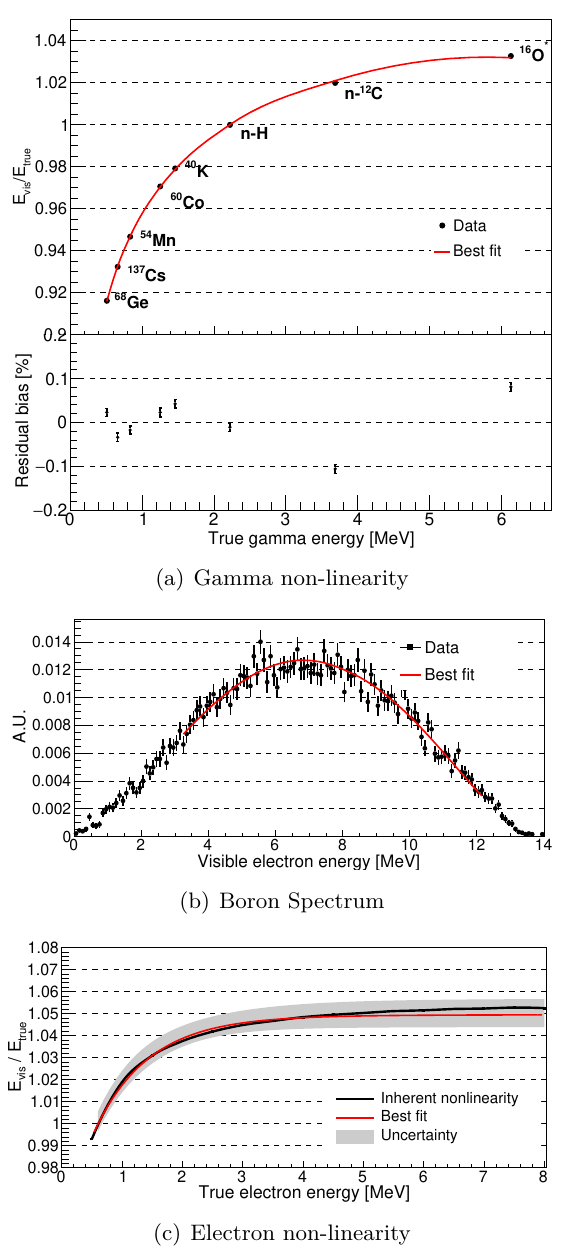
Figure 1 . Fitted and simulated gamma non-linearity (a), 12 B spectra (b), and electron non- linearity (c). In all figures, black points (curves) represent simulated data, and red points (curves) are the best fits. For visual clarity, for sources with multiple gamma emissions, the horizontal axis is chosen to be the mean energy of the gammas. In (c), the uncertainty band is evaluated using the procedure in section